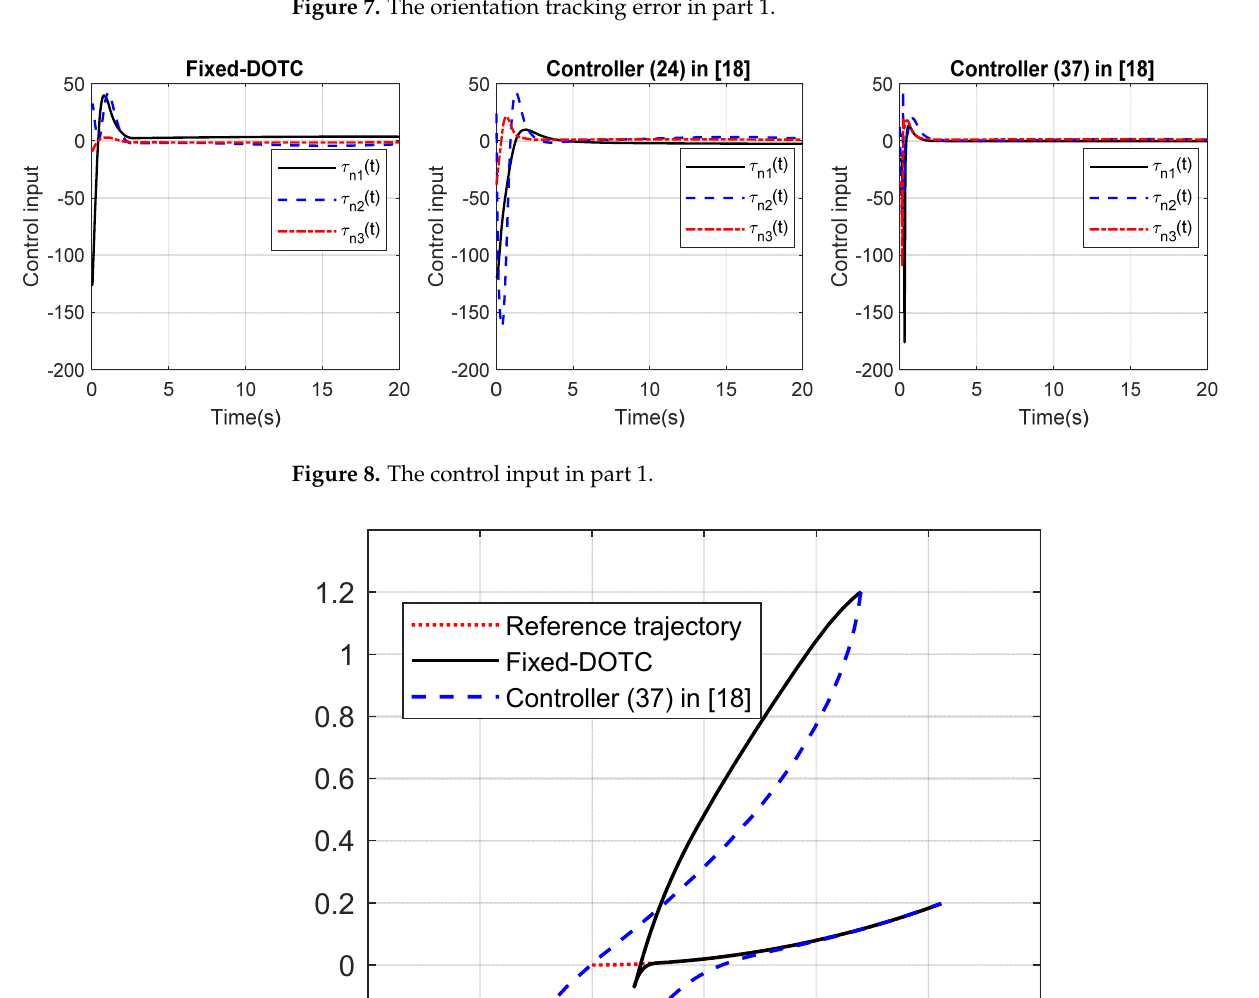
Figure 10. The position tracking errors in part 2. Figure 11. The orientation tracking error in part 2.